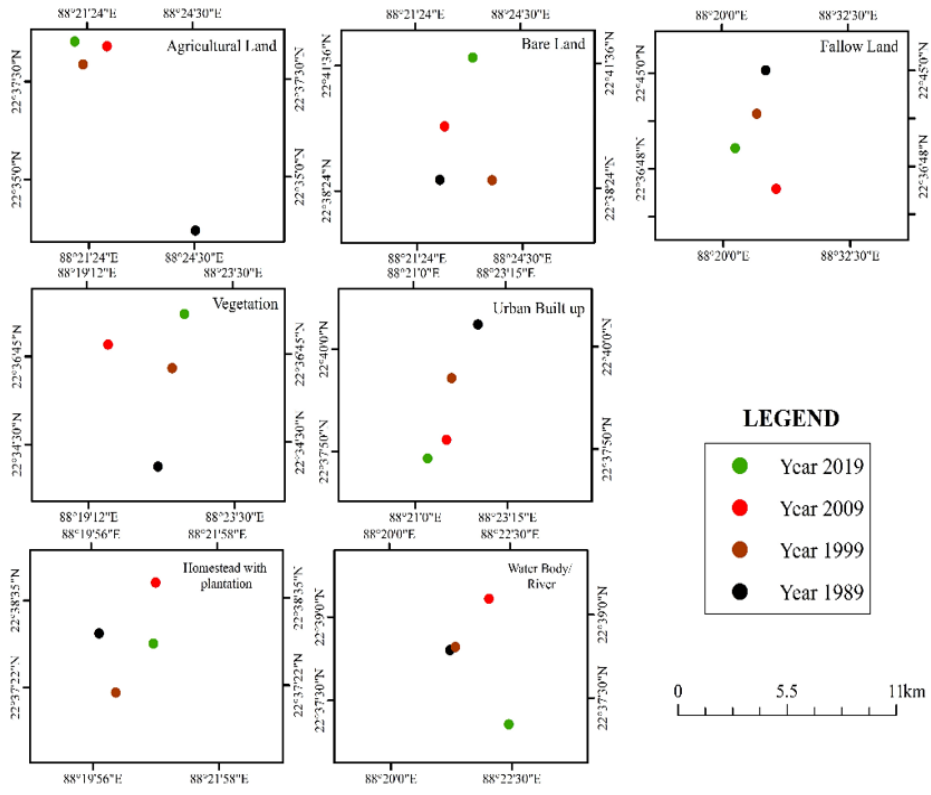
Figure 4. Mean center shifting of each LULC class over the time.